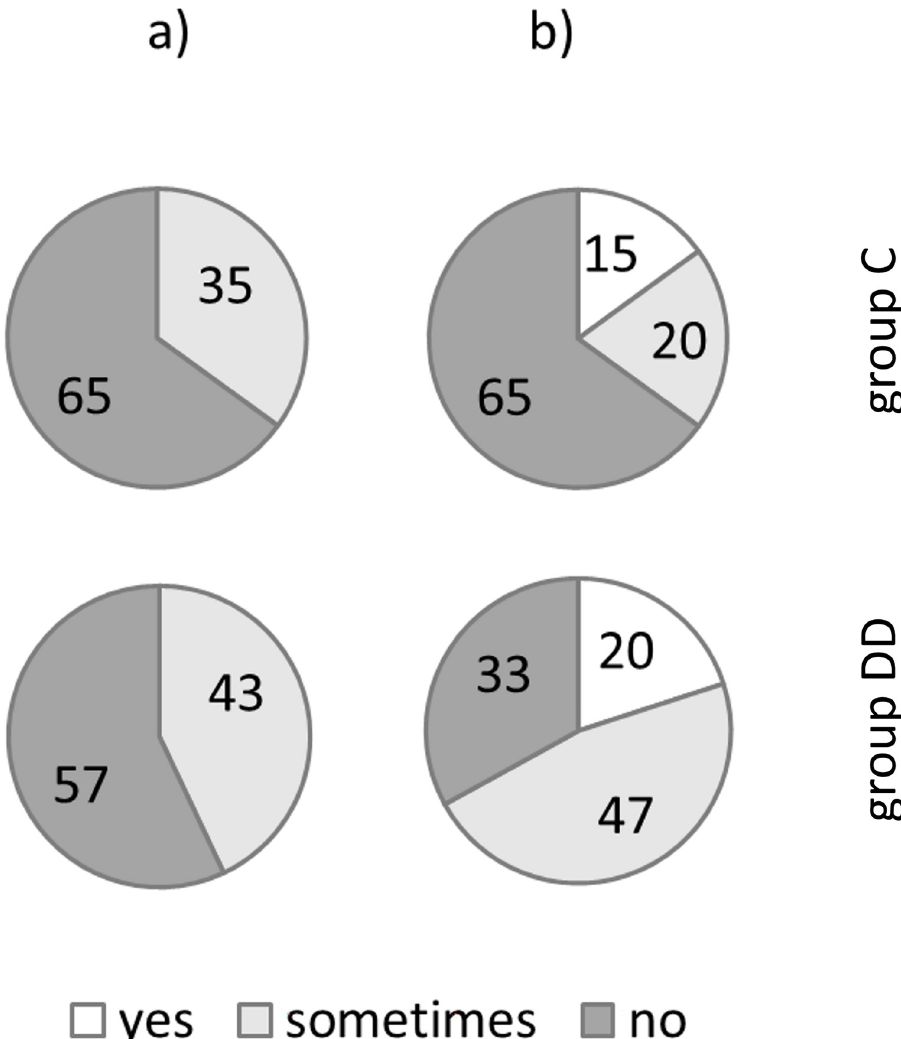
Fig 8. Survey regarding Chinese lessons. Distribution of perceived difficulties while learning Chinese for the children of groups C and DD. Two questions: a) Was it difficult to recall the meaning of the Chinese character (if it was to be named in German)? b) Was it difficult to find the Chinese word for the character? The answers could be: “yes” (white), “sometimes” light grey, and “no” (dark grey). The subjective reports were in agreement with the objective data: The children with dyslexia reported more difficulties, but only for naming in